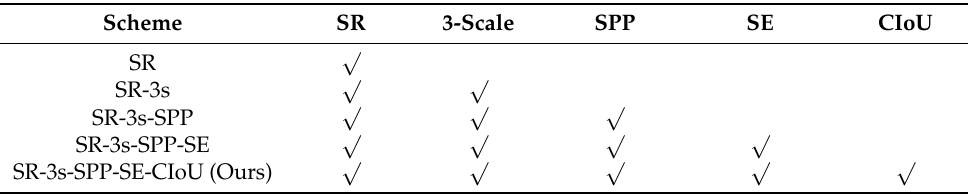
Table 2. Different improvement schemes.